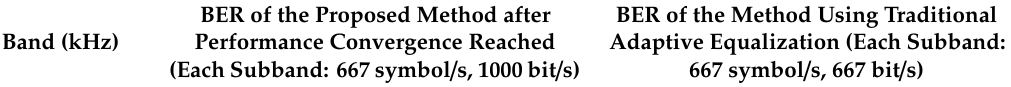
Table 5. Comparison between the proposed method and the method using traditional adaptive equalization in